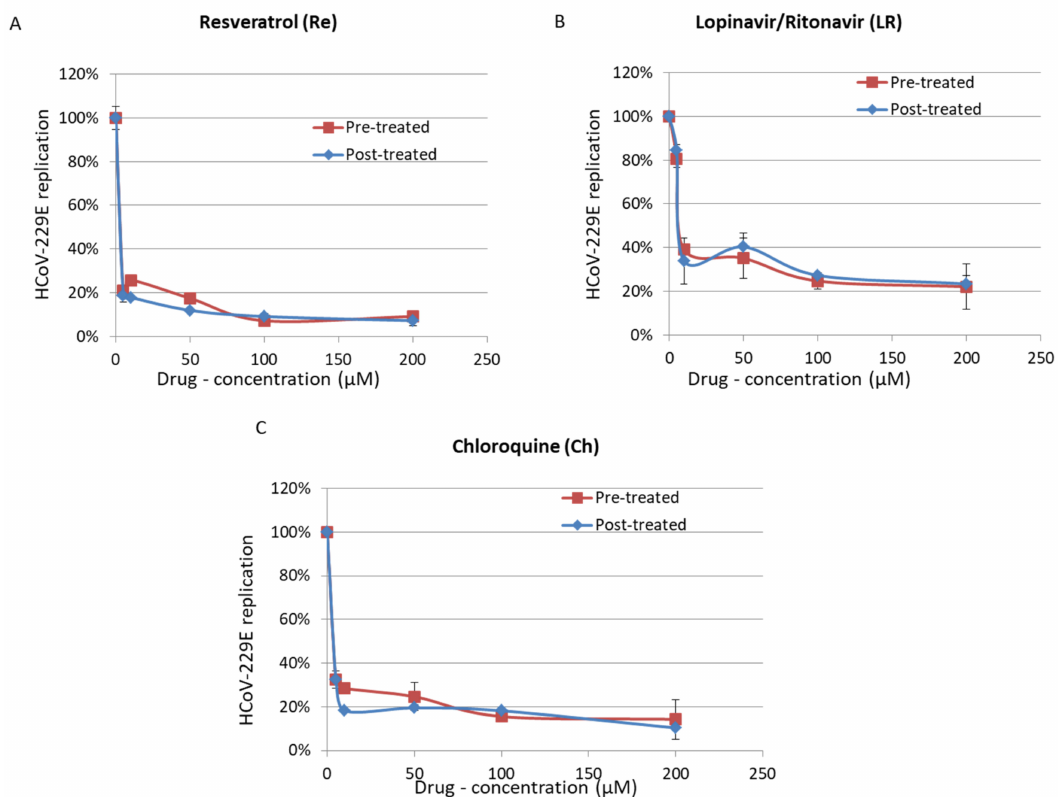
Figure 3. Inhibition of replication of high HCoV-229E viral load (1 MOI) by Resveratrol ( A ), Lopinavir/Ritonavir ( B ) and Chloroquine ( C ) in pre-treated (3 h, Red) or post-treated (4 h, Blue) MRC5 cells. Viral replication was measured by PFU assay after 48 h.